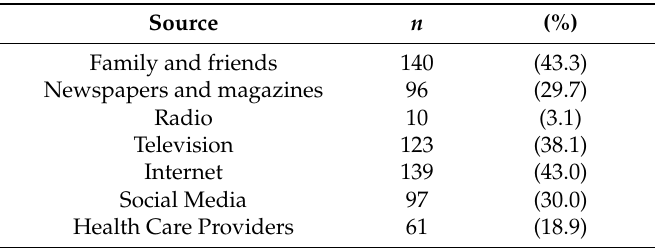
Table 1. Source of HPV Information ( n = 323).